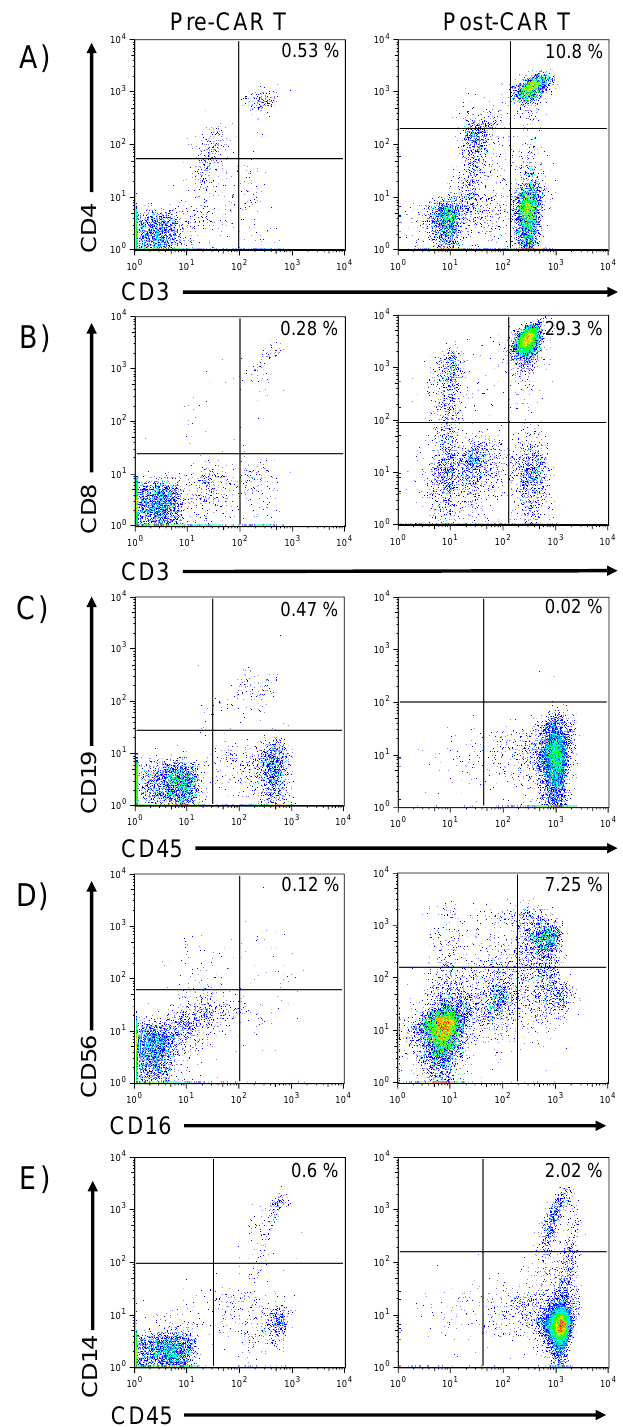
Figure 3. Phenotypic analysis of peripheral blood pre- and post-CAR T infusion. Flow cytometry was performed upon peripheral blood to enable phenotypic analysis of immune system cells, including ( A ): expression of CD3 and CD4 on T cells, ( B ): expression of CD3 and CD8 on T cells, ( C ): CD19 and CD45 expression on B-lymphocytes ( D ): CD56 and CD16 expression on NK cells or cytotoxic T cells, and ( E ): expression of CD14 and CD45 on monocytes. “Pre-CAR T” denotes analysis performed following lymphodepleting chemotherapy but prior to administration of CAR T cells, whereas “Post-CAR T” denotes analysis on post-CAR T cell infusion day 31.